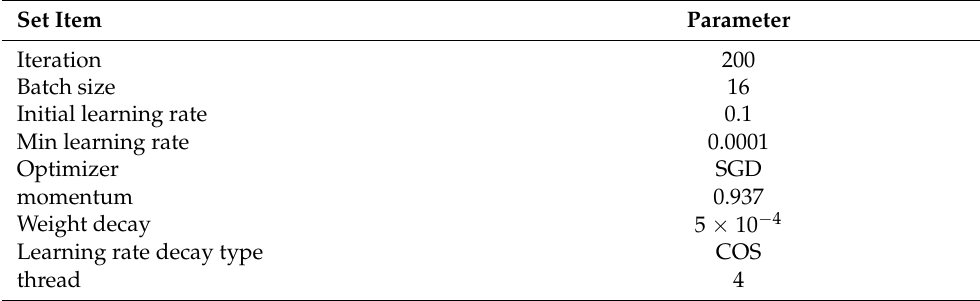
Table 1. Experimental setup.